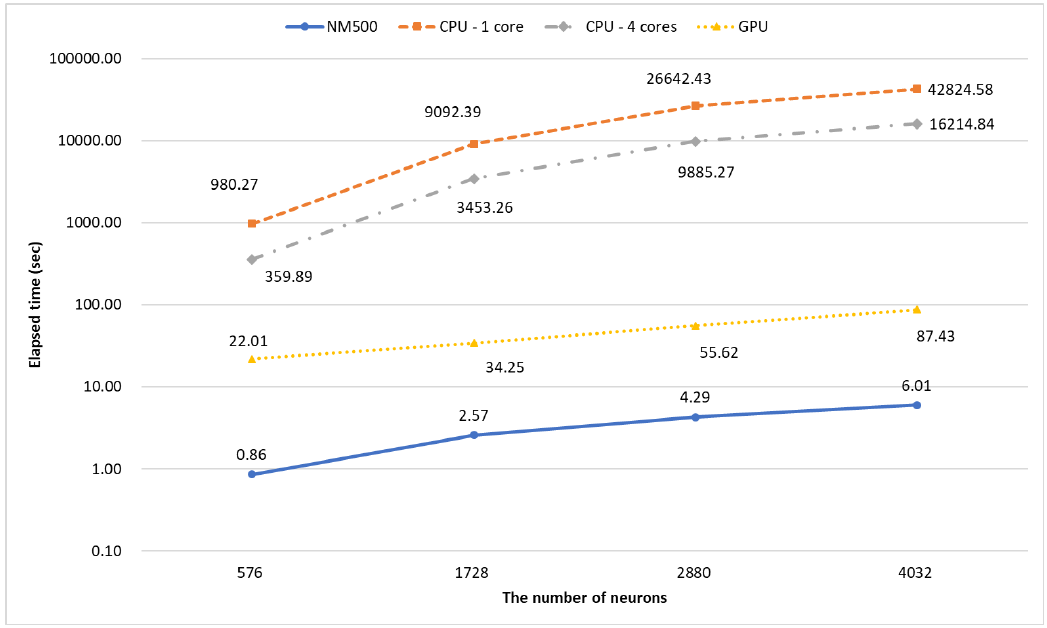
Figure 3. Time to train the model.